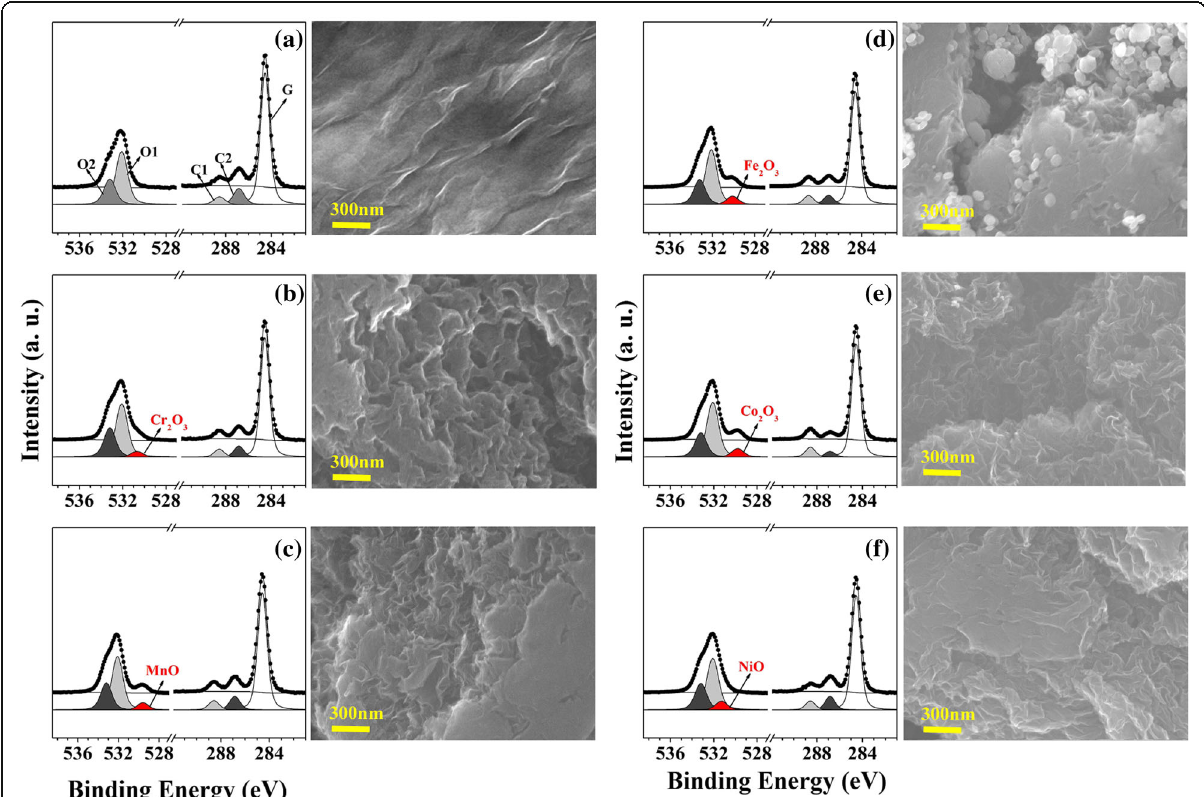
Fig. 1 The HRPES spectra of monodisperse 5 mol % TM-rGO: a rGO, b Cr-rGO, c Mn-rGO, d Fe-rGO, e Co-rGO, and f Ni-rGO and the correspond- ing SEM images,